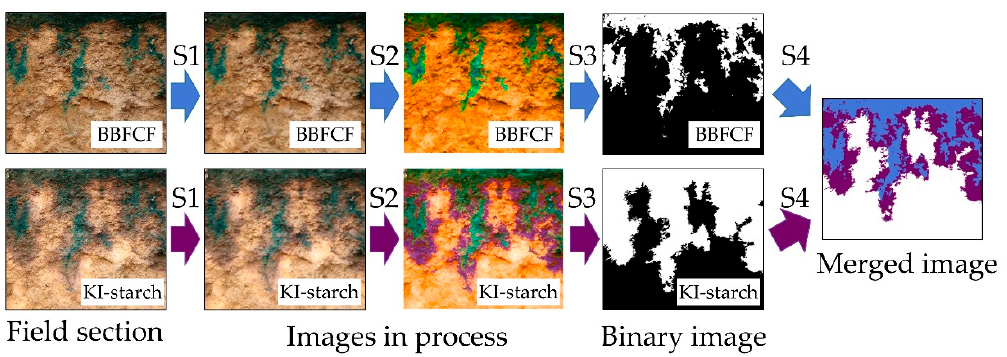
Figure 4. Flow chart of the image analysis procedure for an image of a vertical soil section, taking the 2nd section in Plot C for example. S1 (step 1) was to reduce the noise of the original image from the field section. S2 (step 2) was to maximize the color saturation so as to subsequently recognize target color as the stained area. S3 (step 3) was to binarize the image by replacing the staining color with white and replacing the unstained area with dark, then to extract data to calculate the statistics of the stained pixels in the binary bitmap as well as the preferential flow indices and evaluate the infiltration redistribution. S4 (step 4) was to merge the binary image of Brilliant Blue FCF (BBFCF) with that of KI-starch, replacing the stained area of BBFCF with blue and that of KI-starch with purple for more directly visual comparison.